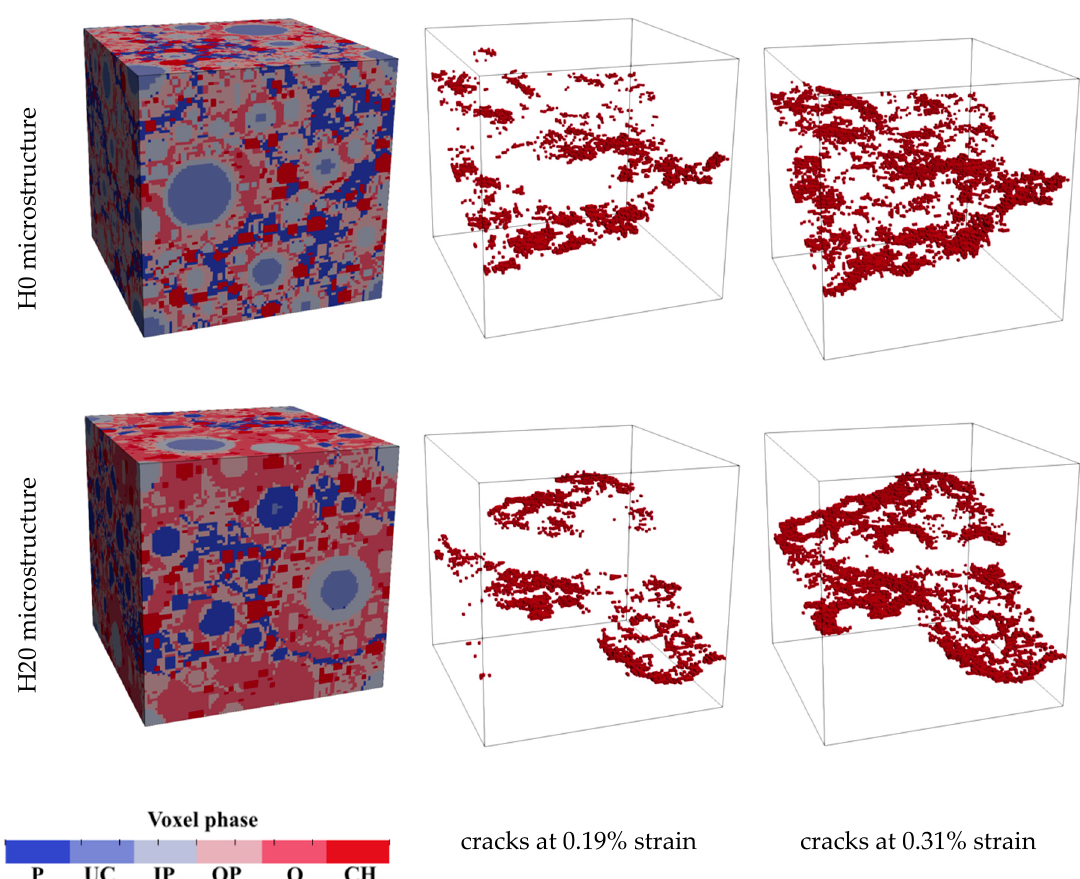
Figure 6. Simulated microstructures and crack development for the two cases. In the legend: P-pore; UC-unhydrated cement; IP-inner product; OP-outer product; O-overlap; CH-calcium hydroxide.